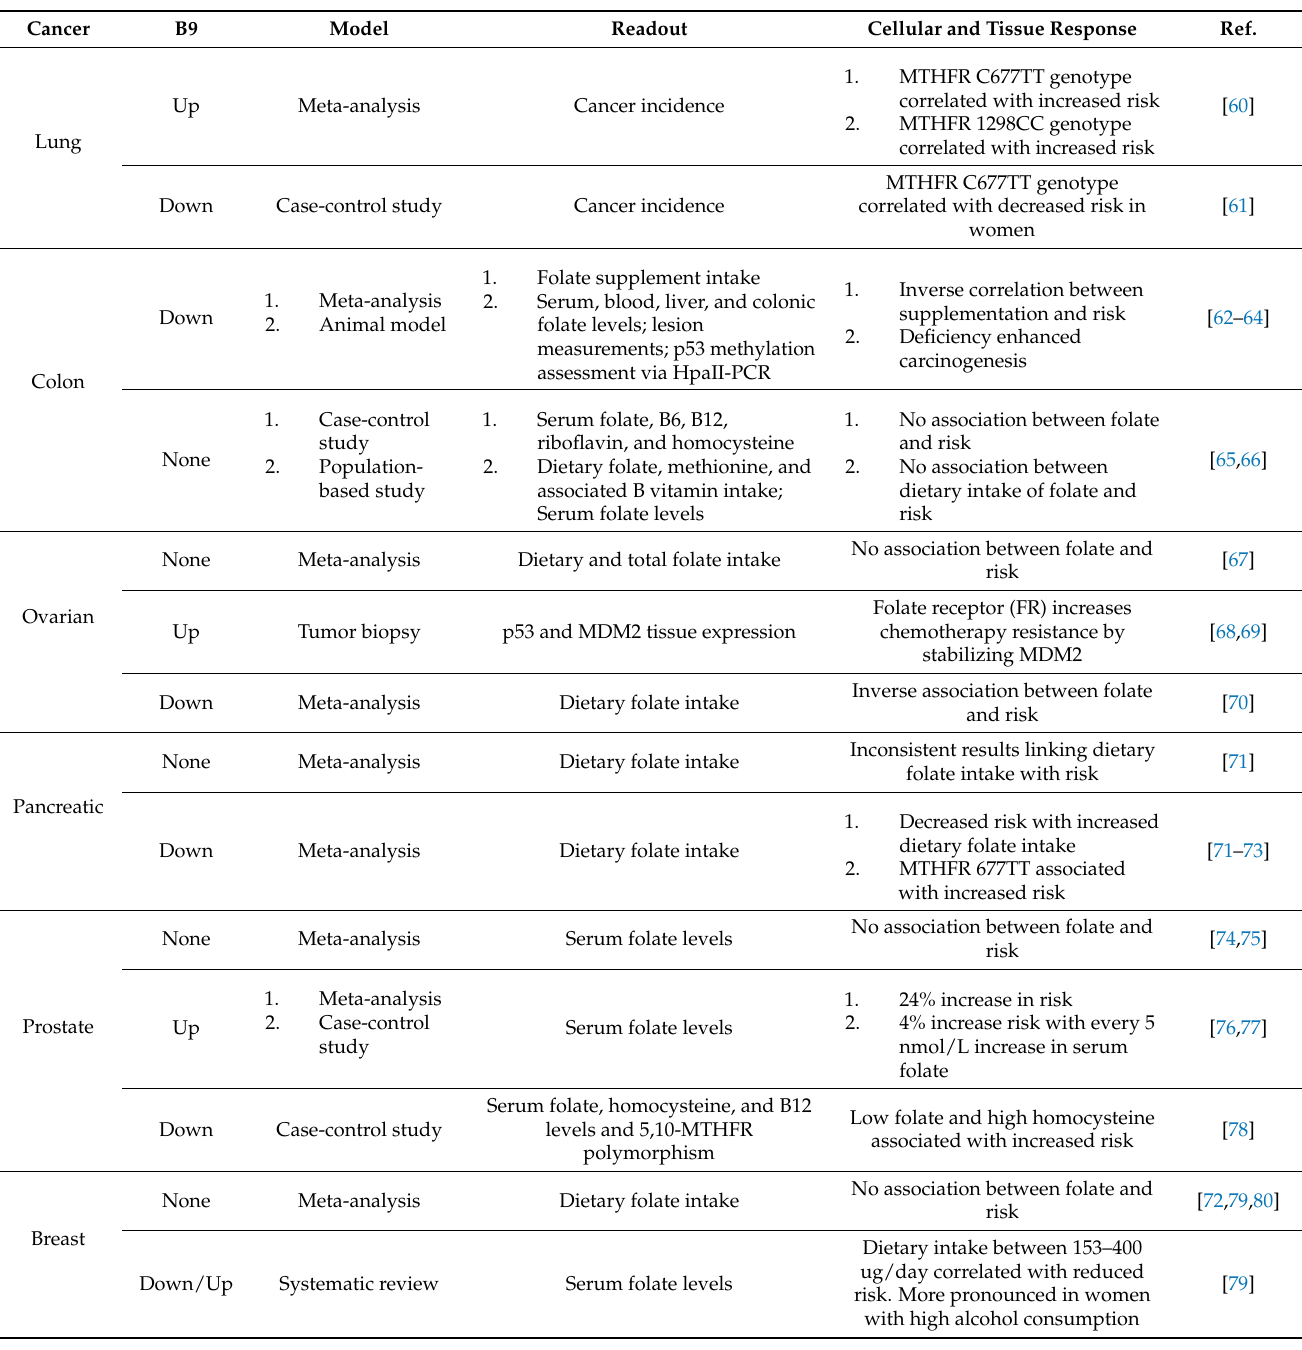
Table 2. Vitamin B9 has been implicated across a spectrum of cancers. Cellular and tissue responses are